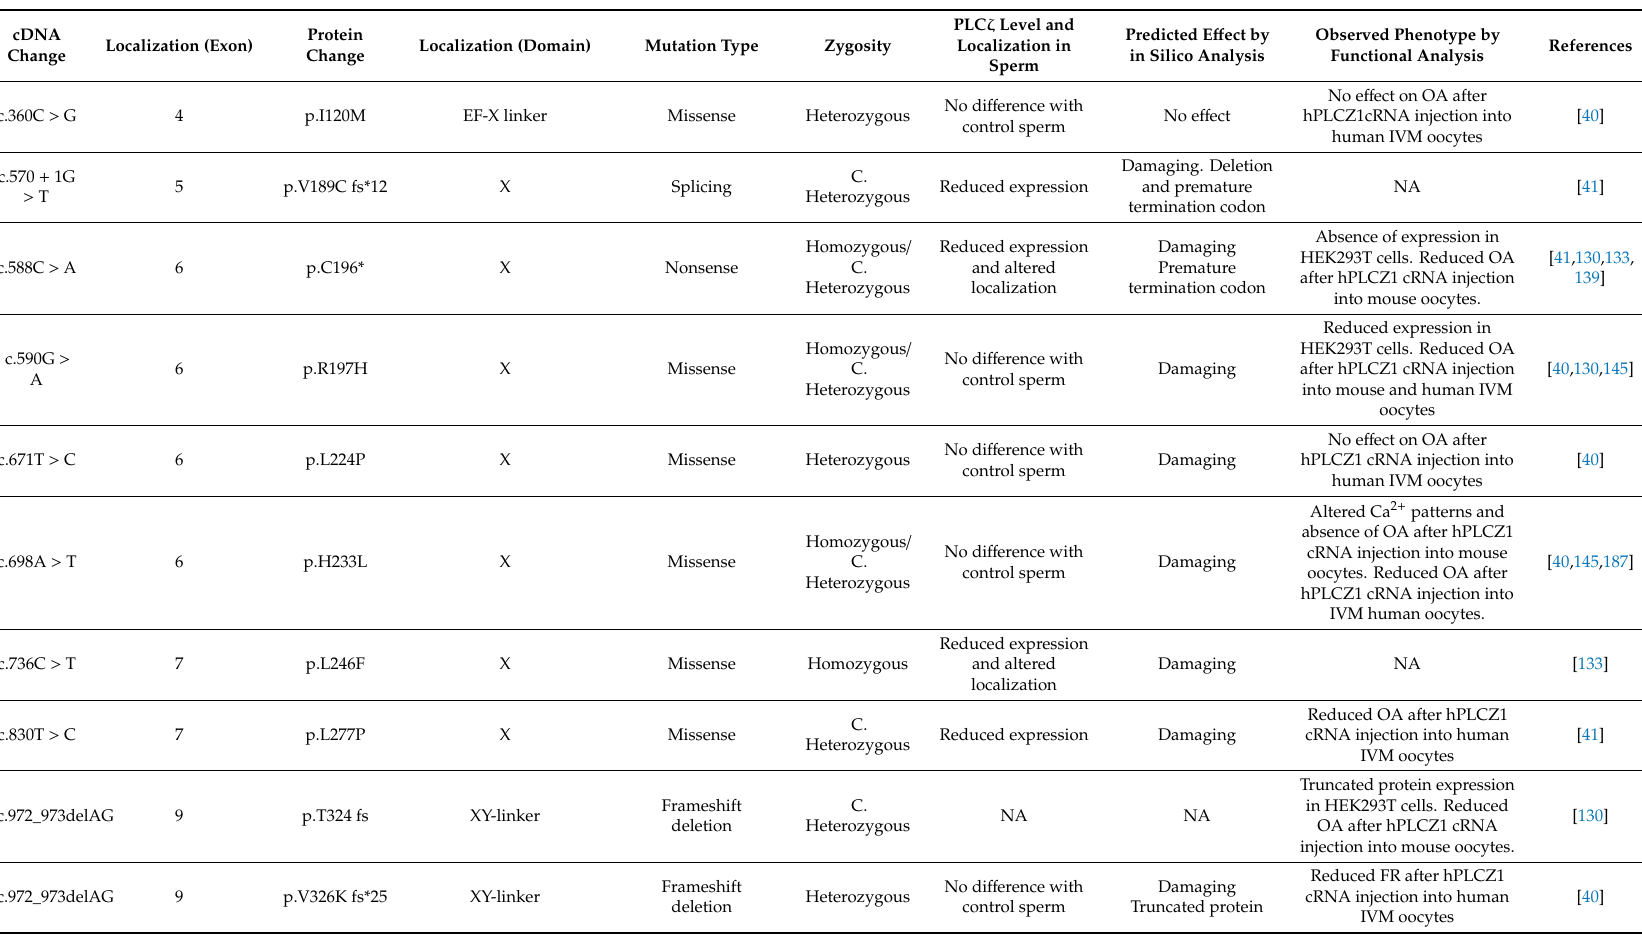
Table A1. PLCZ1 mutations detected in patients with low or total fertilization failure after ICSI.OD: outside domain; OA: oocyte activation; IVM: in vitro matured oocytes; C: compound; h: human; m: mouse; cRNA: complementary RNA; NA: not